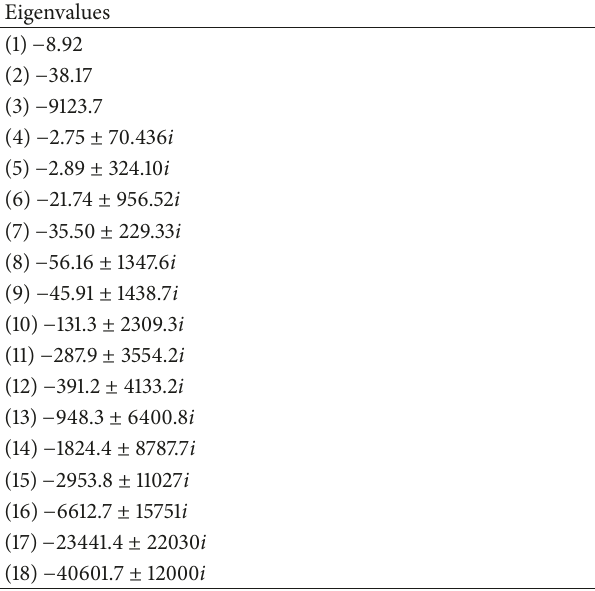
Table 2: Closed-loop system